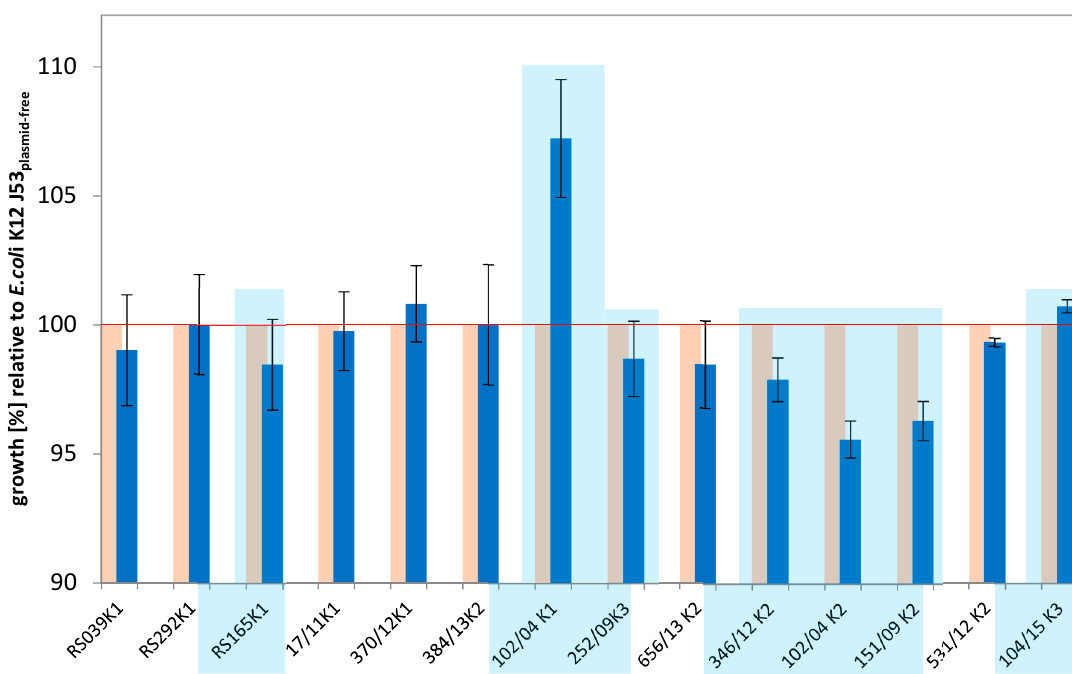
Figure 1. Growth rates of the transconjugants (blue) relative to the growth rate of the plasmid-free recipient E. coli J53 Azir (yellow). Isolates se-lected for further analysis are highlighted by a light blue background.